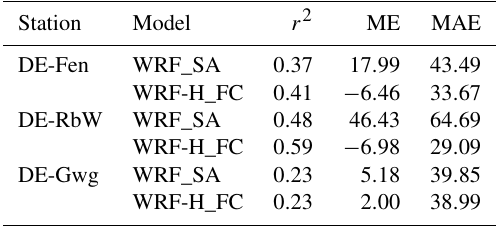
Table 6. Performance measures for sensible-heat flux (Wm − 2 ) with simulations vs. observations for June to October 2016.